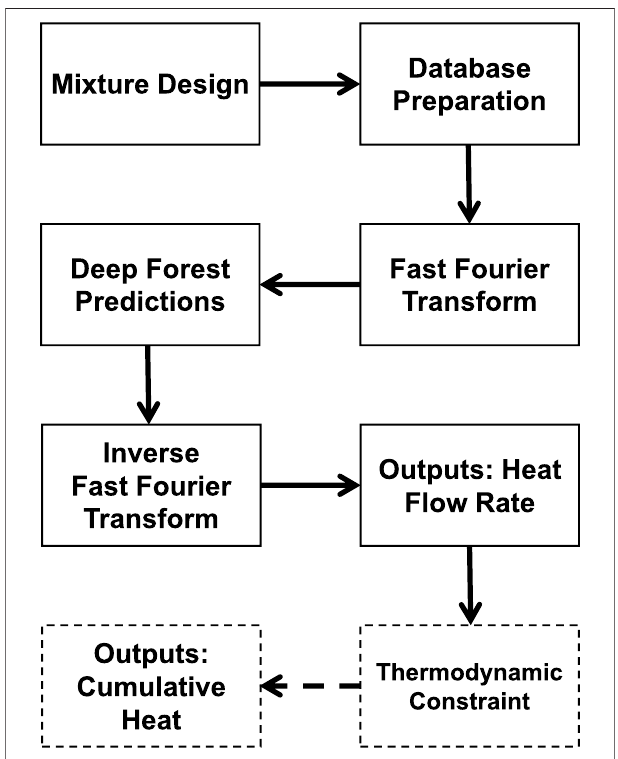
FIGURE 2 | Schematic of the original FT-DL model, developed in this study, to predict hydration kinetics (i.e., heat fl ow rate and cumulative heat release) of (PC + SCM) pastes. For prediction of cumulative heat release, thermodynamic constraint – obtained from simulations of phase assemblages in the pastes – is used to provide guidance to the model, and constrain its outputs.